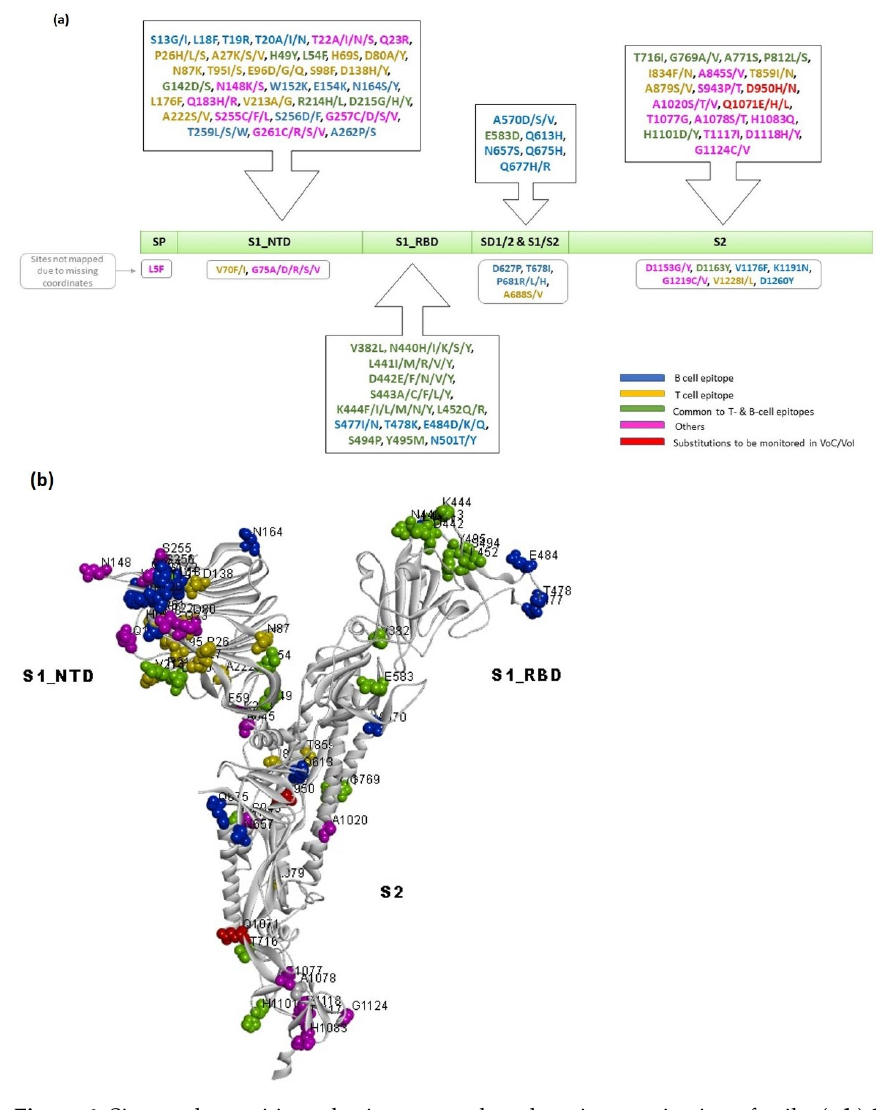
Figure 6. Sites under positive selection mapped on domain organization of spike ( a , b ) 3D structure (PDB ID: 7DF3). Note: Sites are color coded as B-cell epitopes (blue), T-cell epitopes (yellow), common to T- and B-cell epitopes (green), Others (magenta), and substitutions to be monitored in VoC/VoI (red).